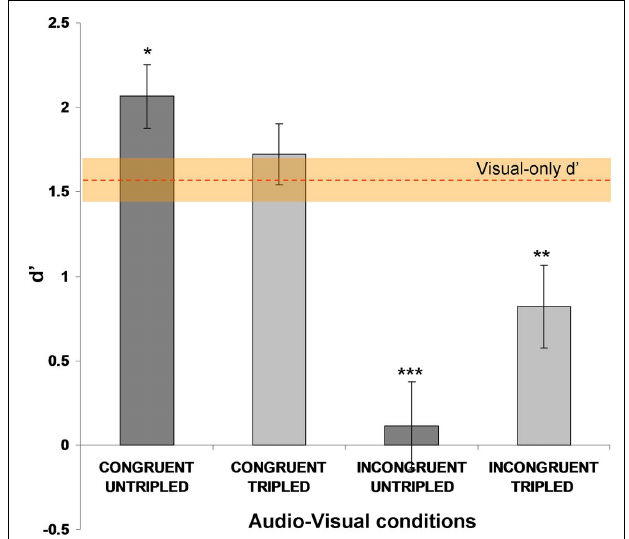
FIGURE 3 | Mean visual duration discrimination sensitivity (d (cid:2) ), SEM indicated) for each condition in Experiment 2. Asterisks above bars point to significant differences relative to the visual-only baseline, with the latter represented here by the orange dashed line with SEM shading.The significant enhancement or decrease of sensitivity, for the untripled congruent and incongruent conditions (respectively) replicates the findings of Experiment 1a.These effects were eliminated or reduced (respectively) for the corresponding two new tripled conditions, in which a sound still onset concurrently with each flash, but the sounds now were three times as